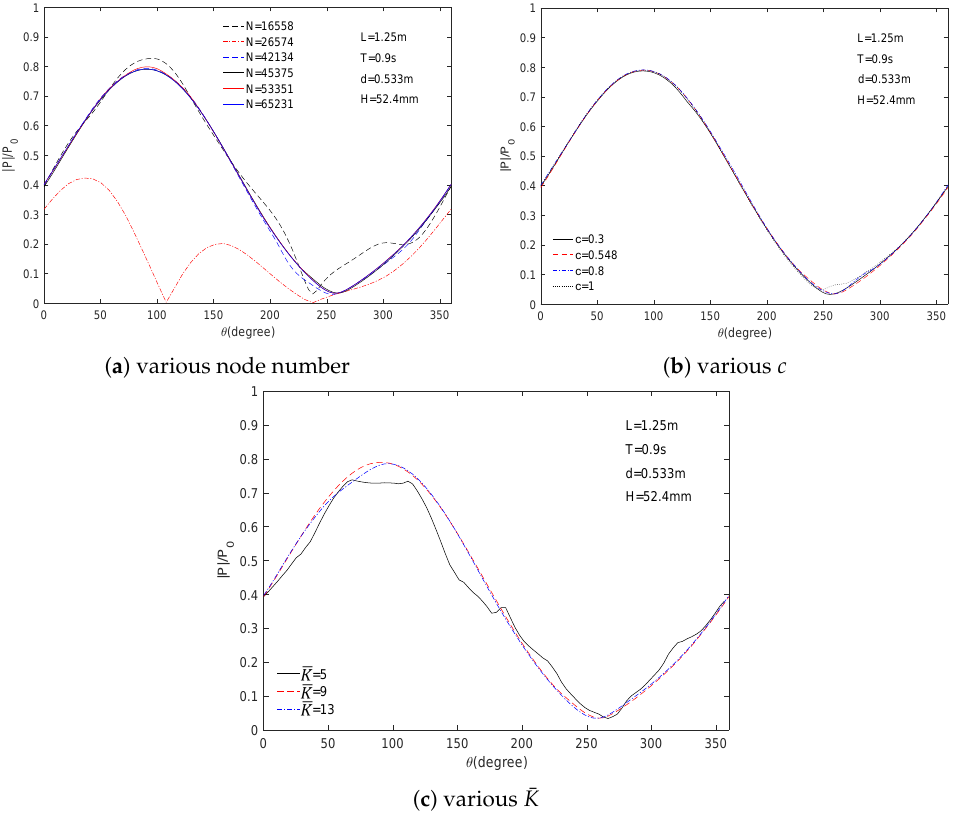
Figure 3. The wave-induced pore pressure in the vicinity of pipeline with various node number, c and ¯ K